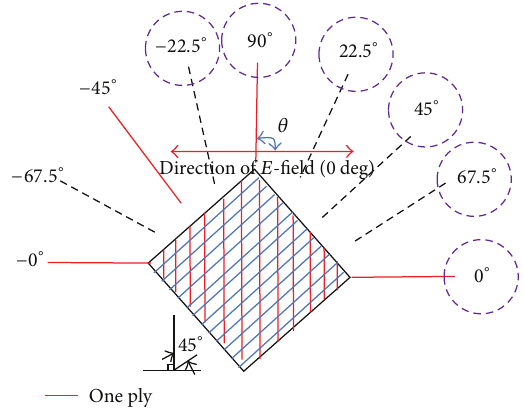
Figure 12: Diagram showing a scan configuration of TDS for scanning and direction of E -field normal to fiber, and 𝜃 is the angle between fiber direction and E -field